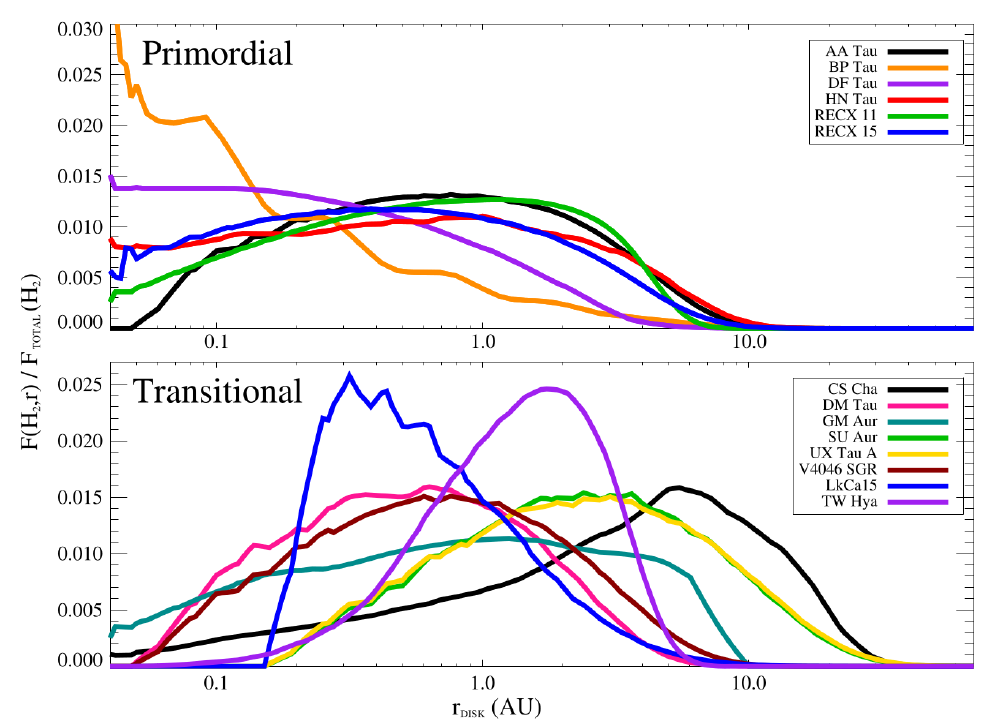
Figure 10. Comparison of full and transitional disks in their reconstructed radial distributions of the observed H 2 emission. From Hoadley et al. [81]. c